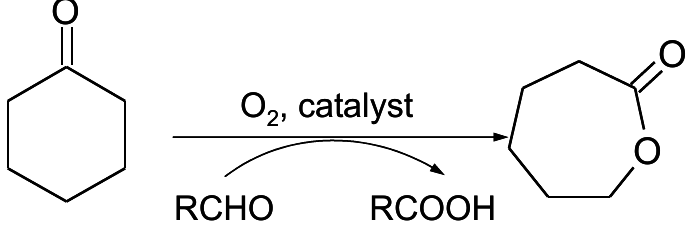
Figure 1. Scheme of catalytic Baeyer-Villiger (BV) cyclohexanone oxidation with molecular oxygen and sacrificial aldehyde—Mukaiyama system.